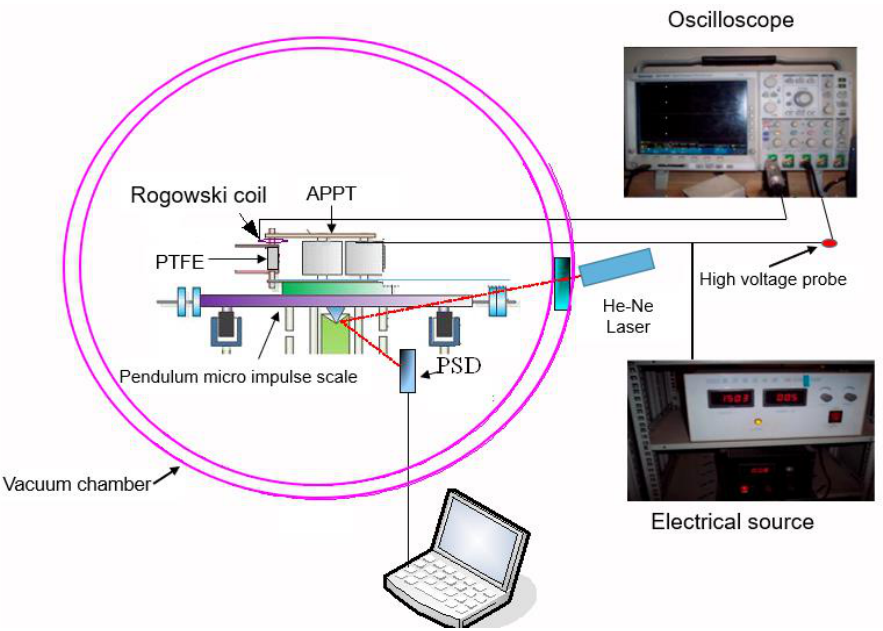
Figure 3. Schematic of the APPT electrical circuit and instrumentation system.